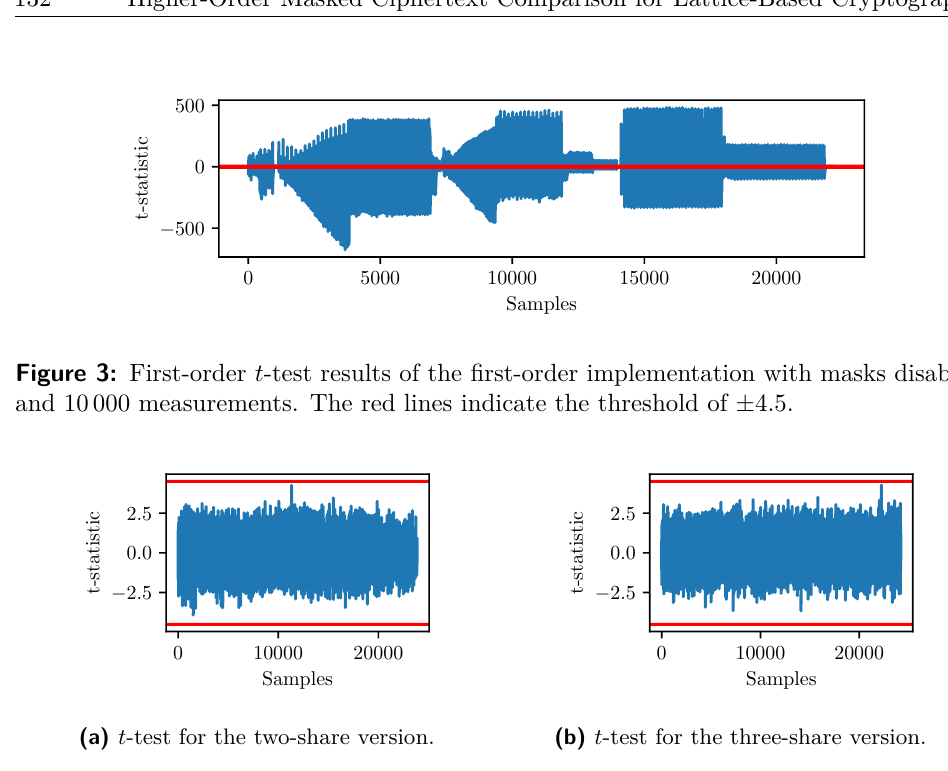
Figure 4: First-order t -test results of the first and second-order implementations with masks enabled and 100 000 measurements. The red lines indicate the threshold of ± 4 .